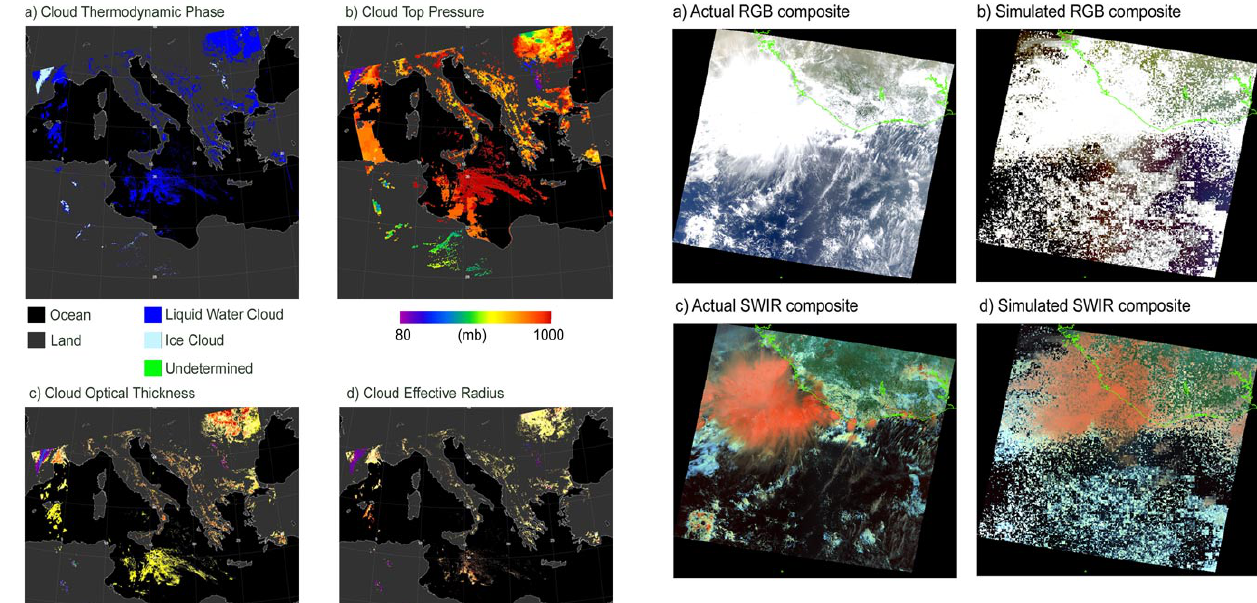
Fig. 5. Synthetic sensor radiance simulation together with an actual MODIS granule that was used as study area. Terra MODIS granule 2013 day 151 at 11:15UTC. GEOS-5 temporal fit between 06:00 and 12:00UTC, 31 May 2013. RGB (0.67µm, 0.55µm, 0.47µm), SWIR(0.86µm, 1.6µm,